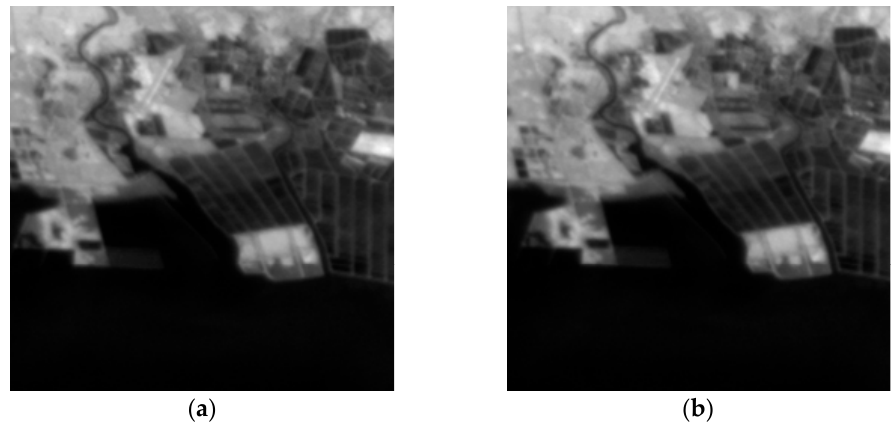
Figure 2. Simulation results of different methods. ( a ) Origin HR image; ( b ) the bicubic upsampled reference image; ( c ) the proposed method; ( d ) the proposed method without photometric registration; ( e ) IBP; ( f ) Farsiu’s algorithm.